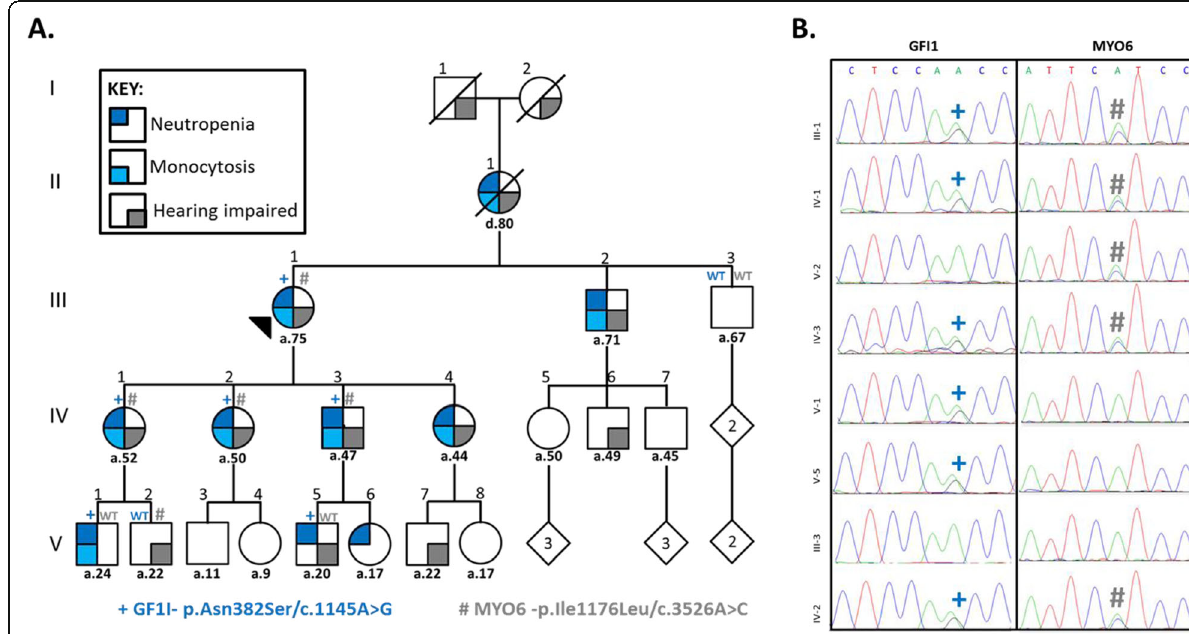
Fig. 1 Family with inherited neutropaenia, monocytosis and hearing impairment associated with mutations in GFI1 and MYO6. Pedigree, phenotypes and mutation status are indicated as per the key provided ( a ). Causative heterozygous mutations in GFI1 (p.N382S/c.1145A > G) and MYO6 (p.I1176L/c.3526A > C) were identified by whole exome sequencing performed on III-1 and IV-1. Sanger sequencing on available samples from consenting individuals was used for segregation analysis and confirmation of variants in individuals denoted by ‘ + ’ and ‘ # ’ , respectively ( b